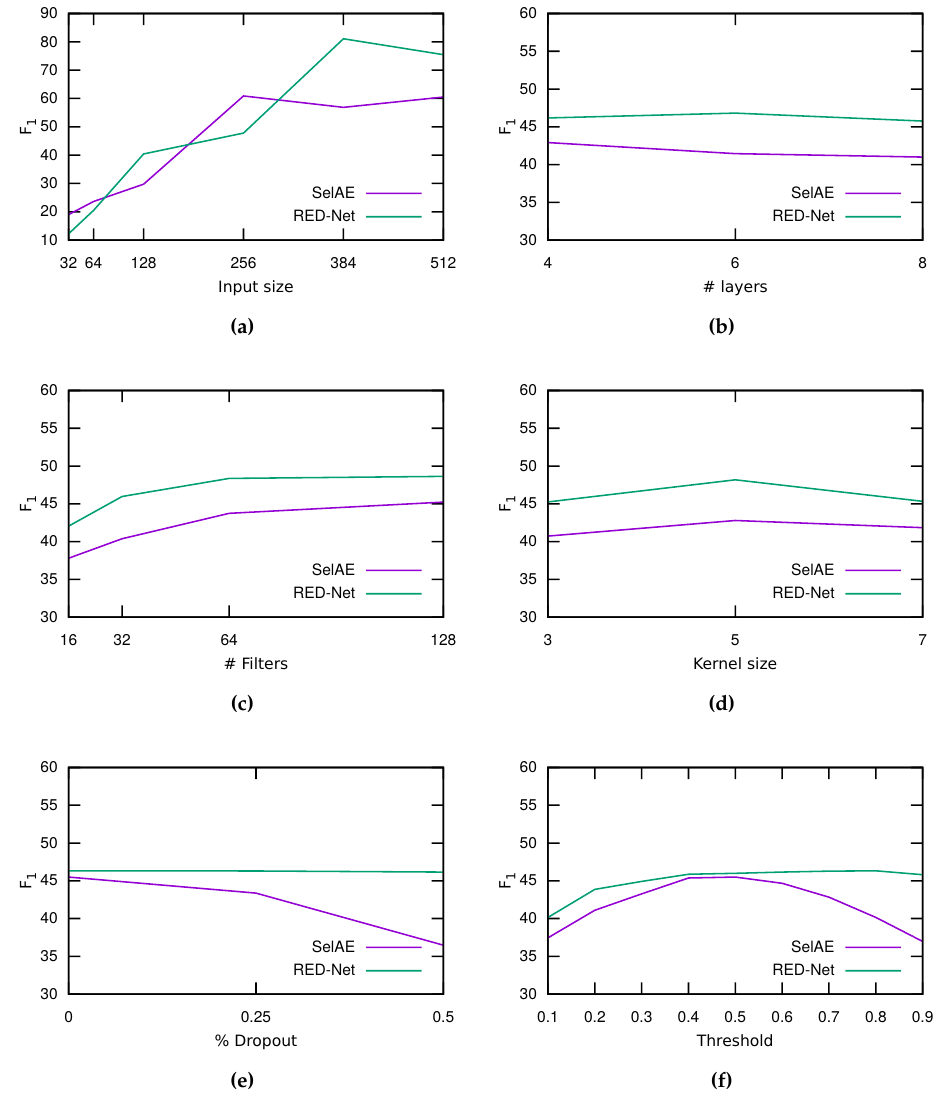
Figure 6. Average F 1 (%) of the grid-search process when varying (a) the input image size, (b) the number of layers, (c) the number of filters per layer, (d) the kernel size of the convolutional filters, (e) the percentage of dropout, and (f) the selectional threshold δ .